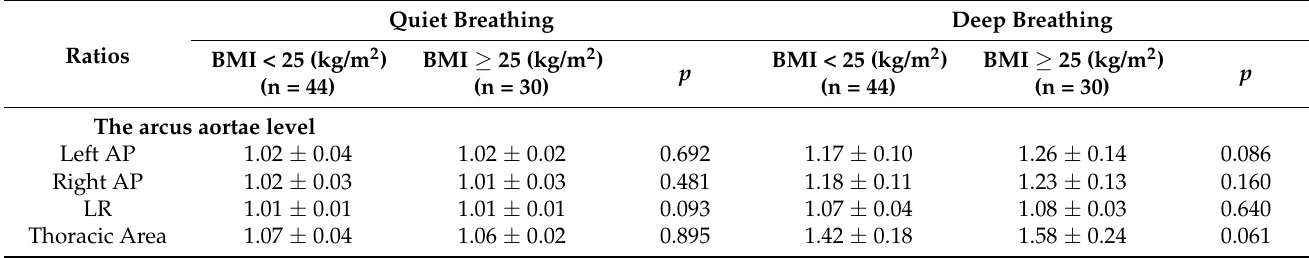
Table 3. The correlation of chest wall and diaphragmatic motion with